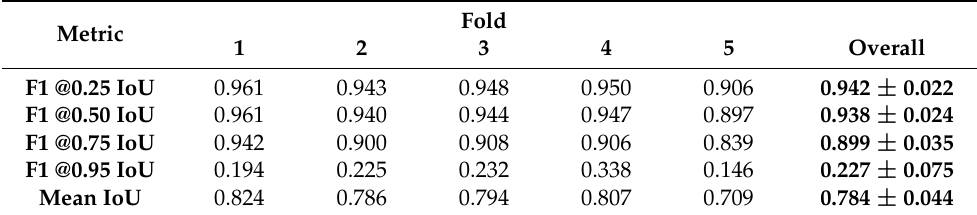
Table 3. Results of experiment 1 . yolo was trained and evaluated in a five-fold cross-validation. The task is the detection of the class polar bear . The F1 score is calculated at different IoU thresholds (cid:101) ∈ { 0.25,0.5,0.75,0.95 } for the definition of a valid detection. Additionally, the mean IoU is given in the last row.